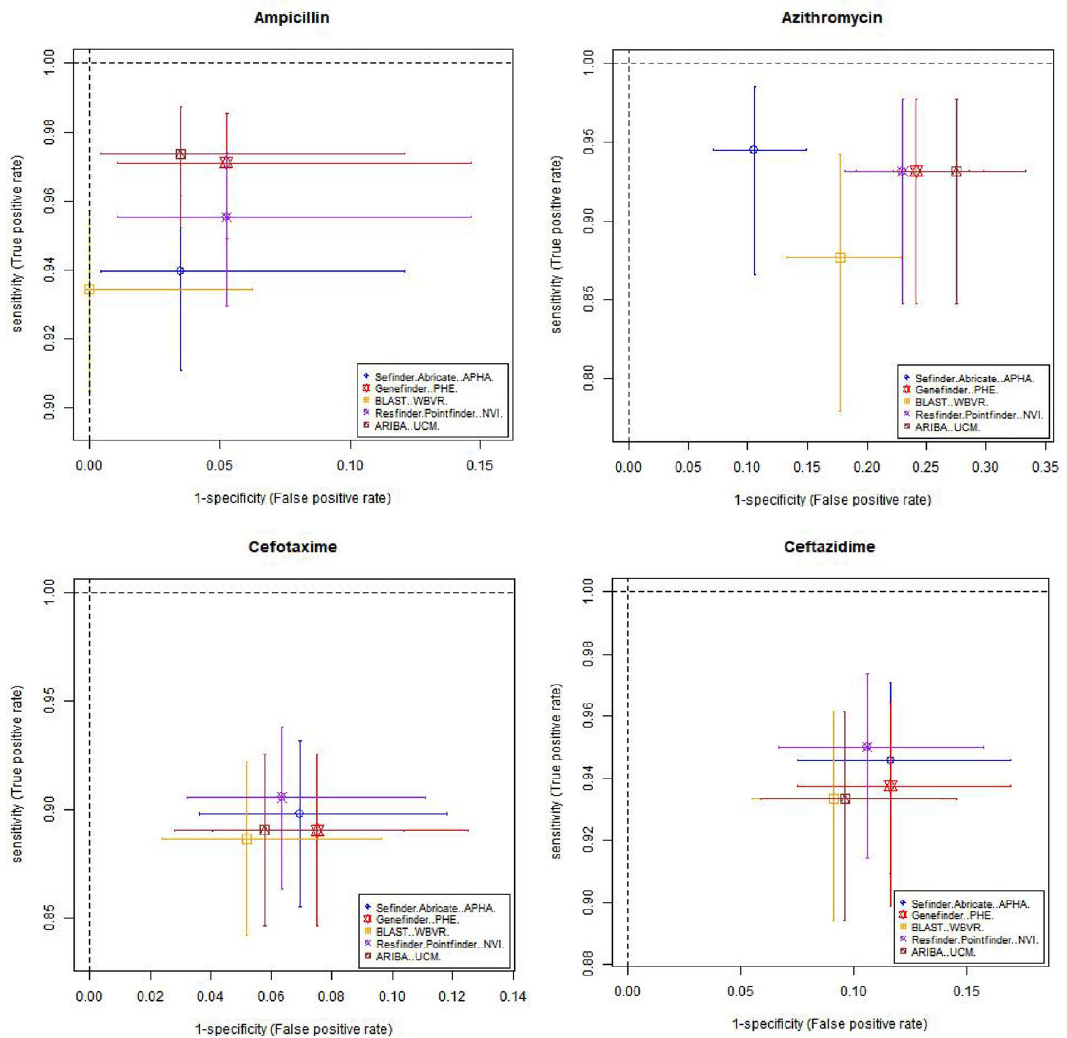
Figure 1. Graphical representation of the sensitivity and specificity values (and 95% confidence intervals) for each antimicrobial detected by the 5 pipelines on the receiver operating characteristic (ROC) coordinate system. As there is one isolate with resistance to tigecycline, its sensitivity value was equal to 1 for all the